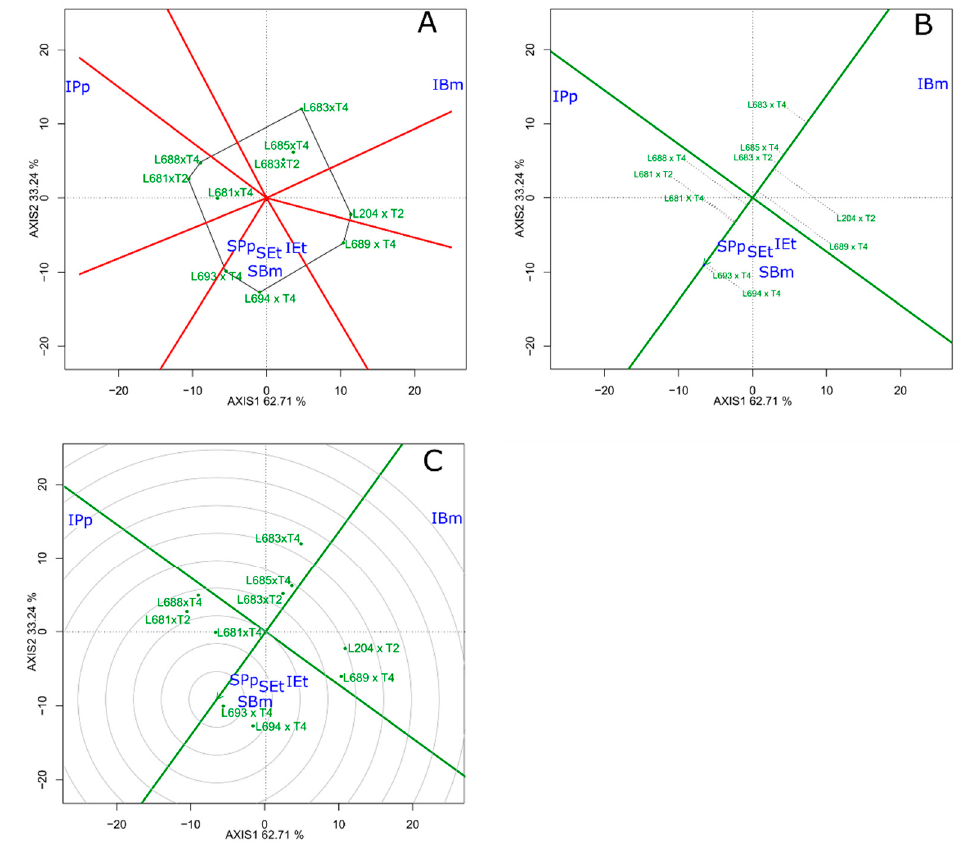
Figure 4. GT biplot plots, where ( A ) refers to the “which-won-where” dispersion, ( B ) refers to the averages versus stabilities containing the ranking of ten popcorn–corn hybrids with their respective stabilities, and ( C ) refers to the estimate of an ideal genotype.